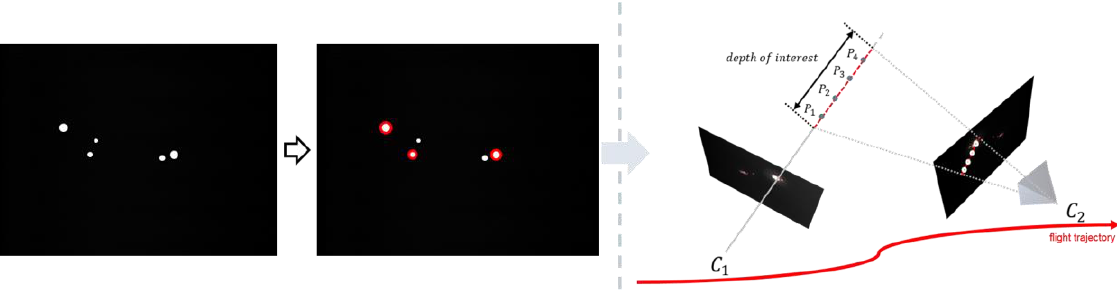
Figure 9. Outline of the UV inspection module from blob detection (left) to partial discharge detection in 3D (right).